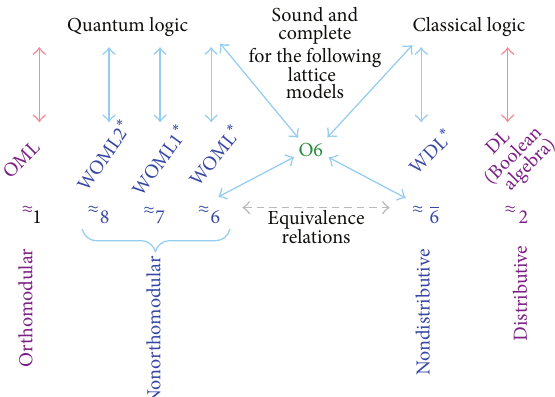
Figure 2: Lattice models of quantum and classical logic together with the corresponding equivalence relations which define their Lindenbaum-Tarski